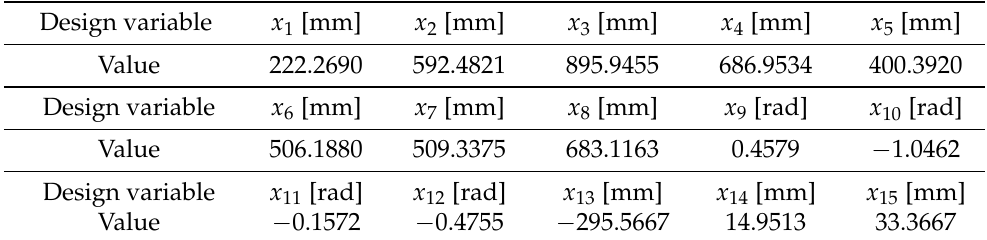
Table 17. Design variable vector obtained by R1B-NCH for study case